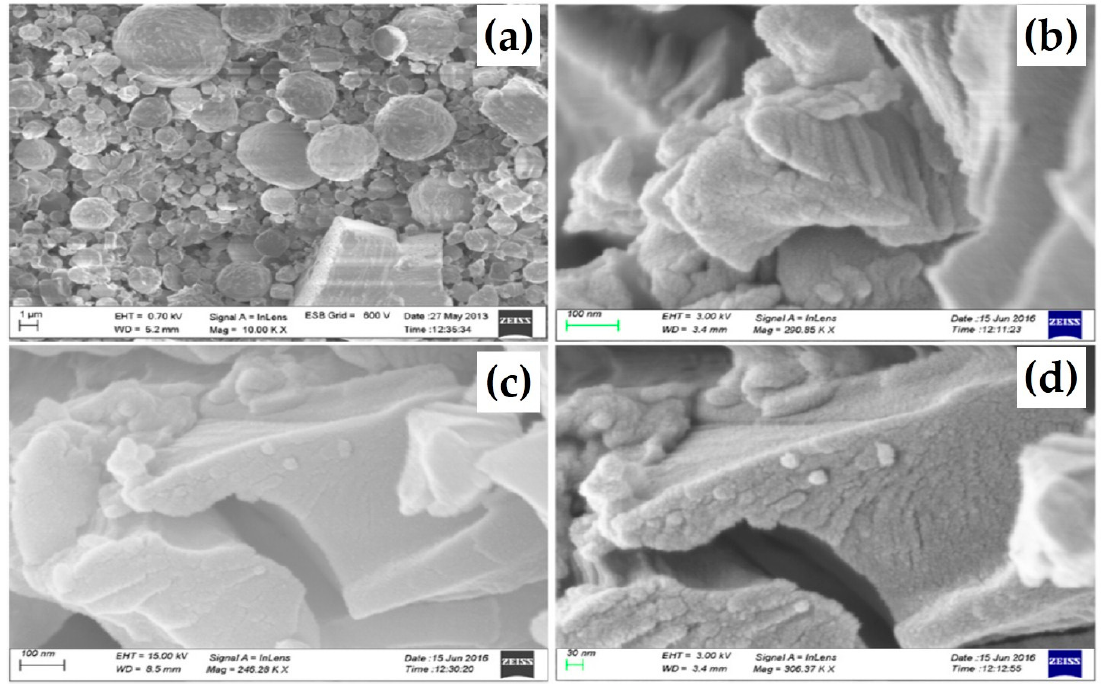
Figure 9. Cryo-SEM images of ( a ) parent RTAQ showing globular structures; ( b , c ) 3 wt% AgNDs/RTAQ in well pattered layer structures; and ( d ) enlarged portion of ( c ) showing bulges of nanodisks covered with discotic molecules. Reproduced with permission [70].